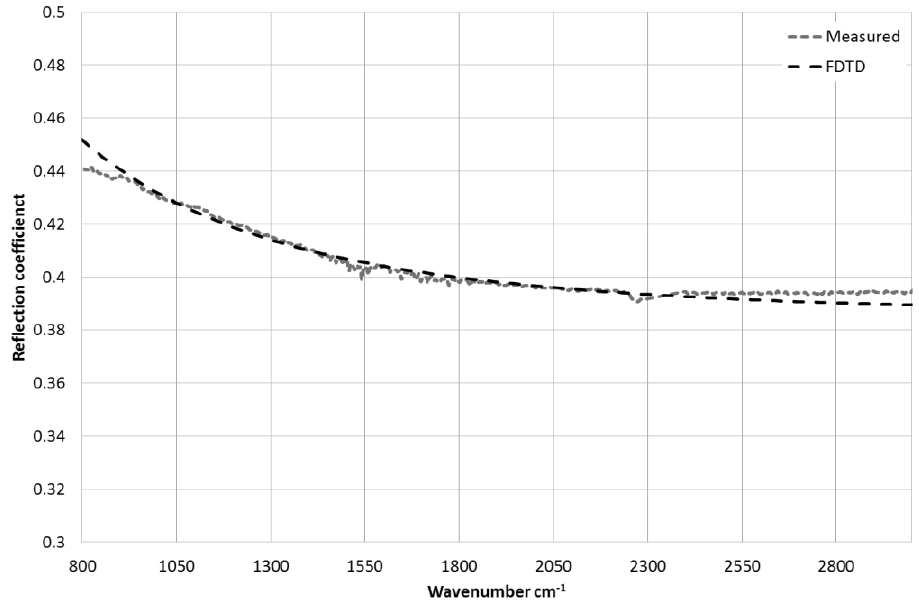
Figure 7. Measured and modelled reflection from a phosphorous doped germanium (n-Ge) thin film of thickness 40 nm, and cut-of frequency ( ω c ) 1582 cm −1 .